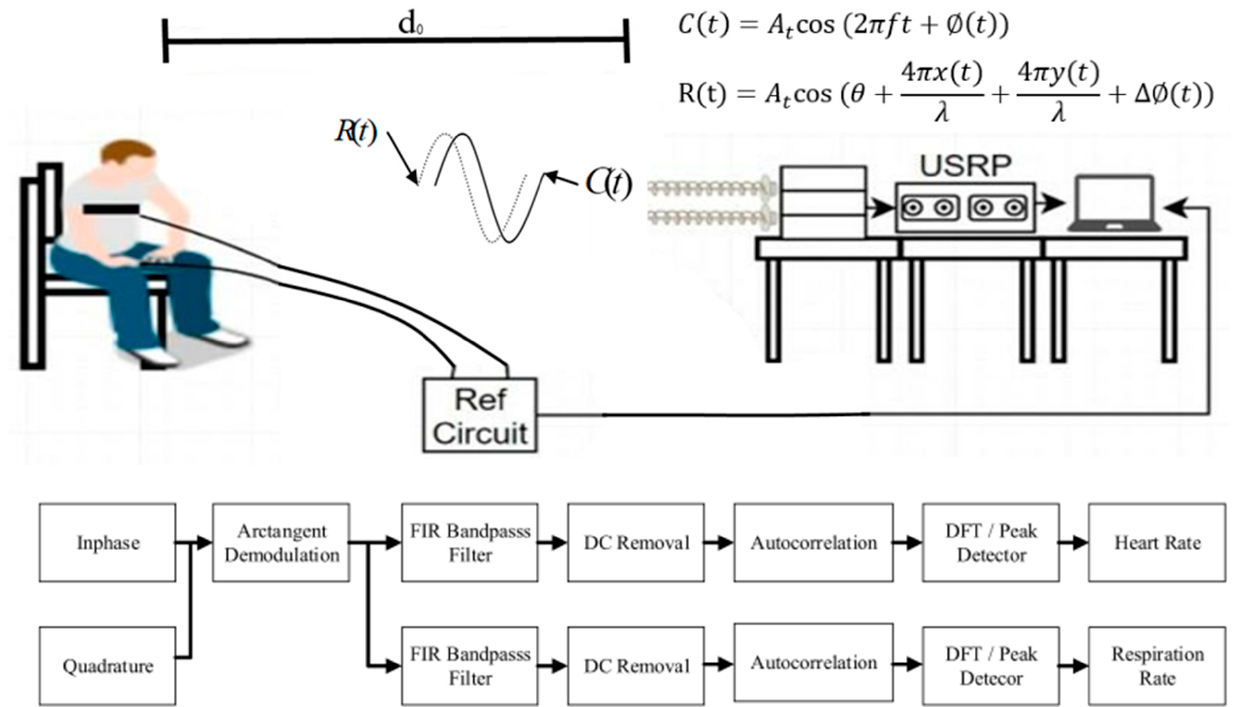
Figure 1. Basic experimental setup of our Doppler-based NCVS detection system using the NI SDR, and the block diagrams showing how to extract the vital signs information [5].